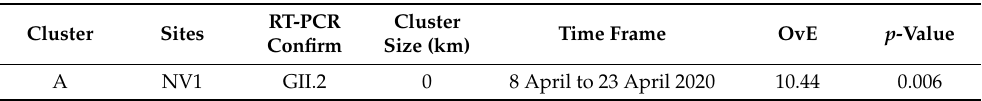
Table 2. A single cluster of GII HuNoV was detected in the Sound between January and April 2020 using the Bernouilli model available in SaTScan